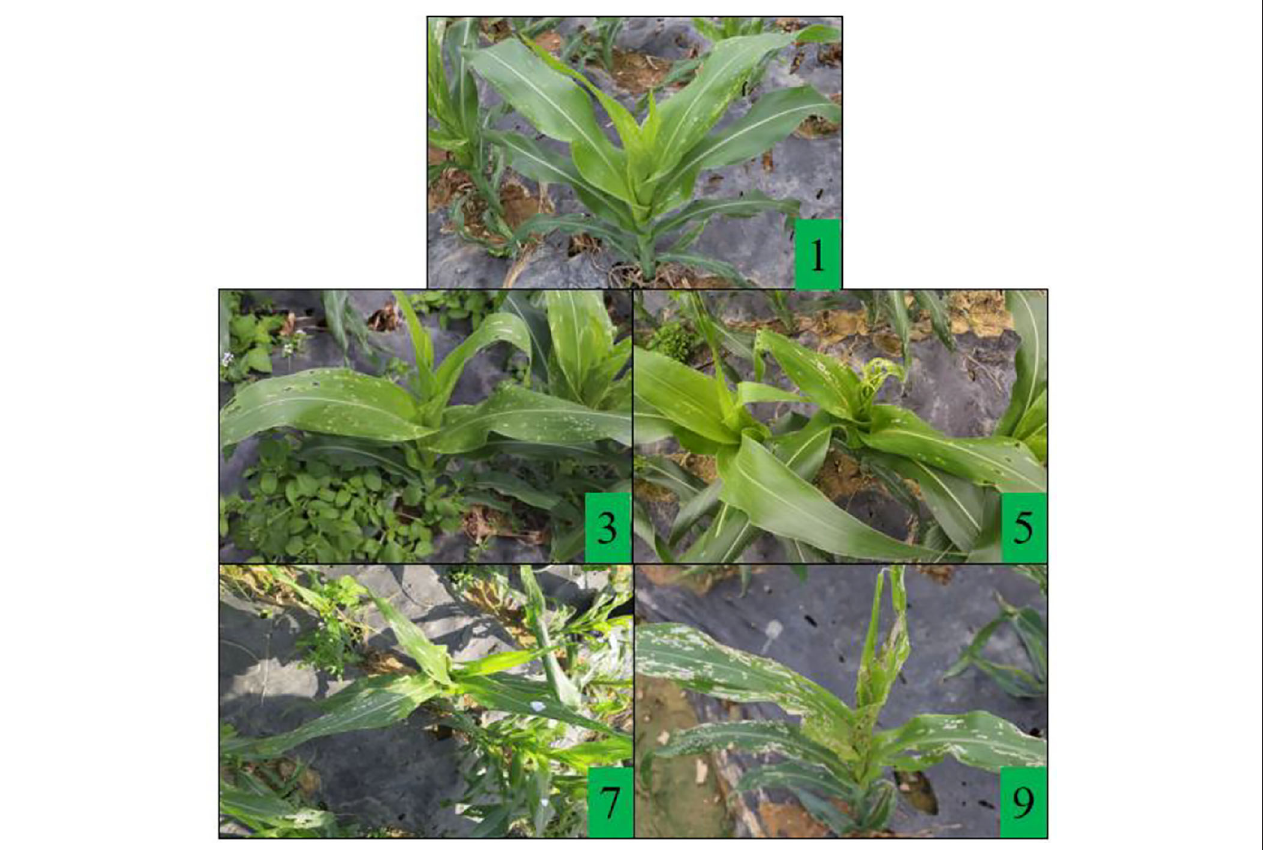
FIGURE 3 | A visual map of some different damage levels of corn fall armyworm. (1) There was only needle-like damage on the leaves, and the damaged area was < 5%. (3) There were pin-eye or small annular lesions on the leaves, and the damaged leaf area is between 6 and 15%. (5) Several small and medium irregular holes appeared on the leaves, and the damaged area was between 16 and 25%. (7) There are many large, elongated lesions on the leaves, ranging from 26 to 50% of the damaged area. (9) Corn leaves are destroyed and it is difficult to restore normal